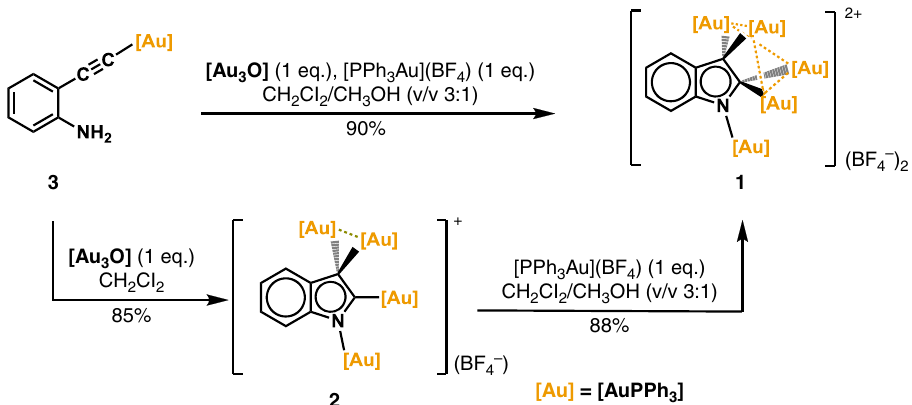
Fig. 2 Synthetic procedures for the penta-aurated complex 1. Both a direct and an indirect pathway are shown to highlight the intermediate role of complex